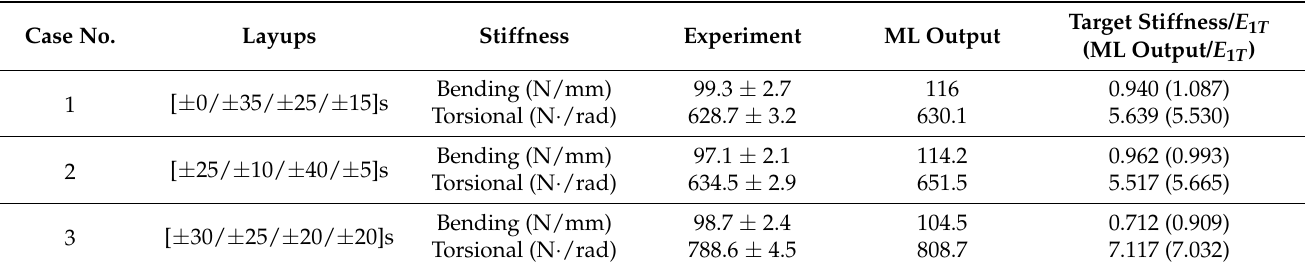
Figure 5. The experimental record curve. ( a ) The force–displacement curves for the three composite tubes under the cantilever bending test. ( b ) The torsion–torsion angle curves for the torsion test. Table 4. A comparison of the stiffness between the experiment and ML output under different layup